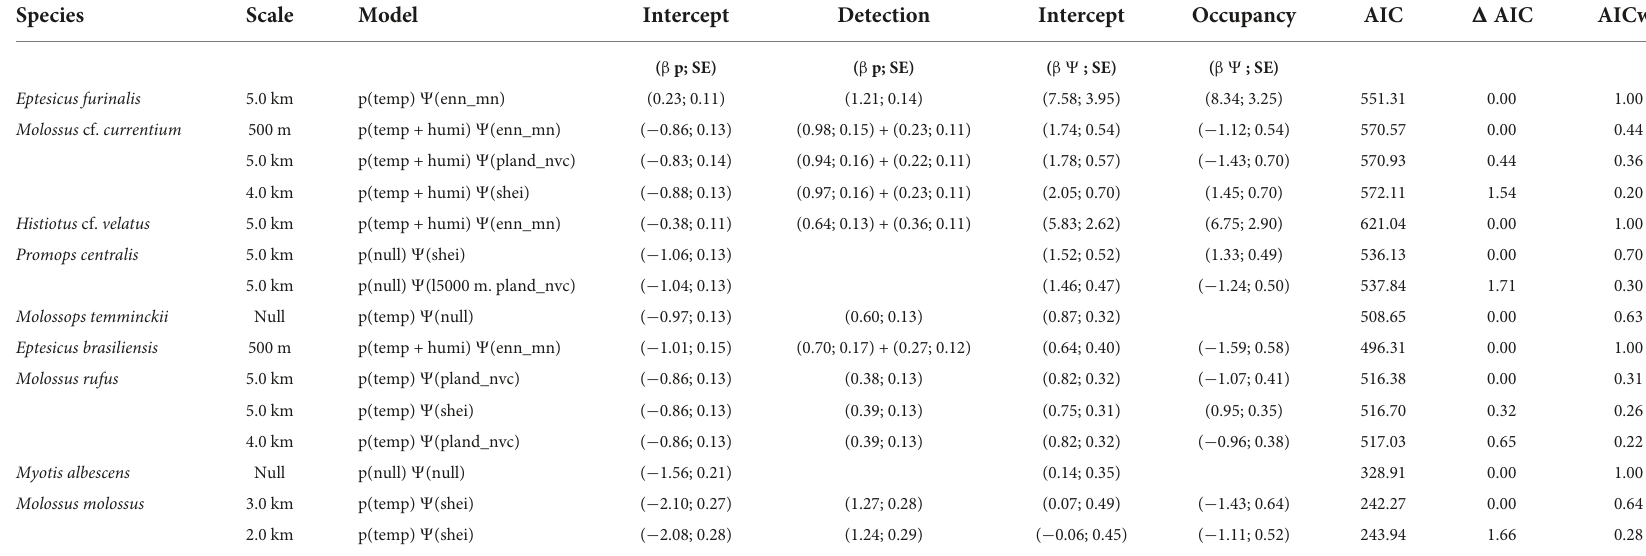
TABLE 3 Summary of the best-fit models and the significant variables for detection (p) and occupancy ( (cid:57) ) for nine species of bats recorded in the Brazilian Pampa during spring and summer 2019 and